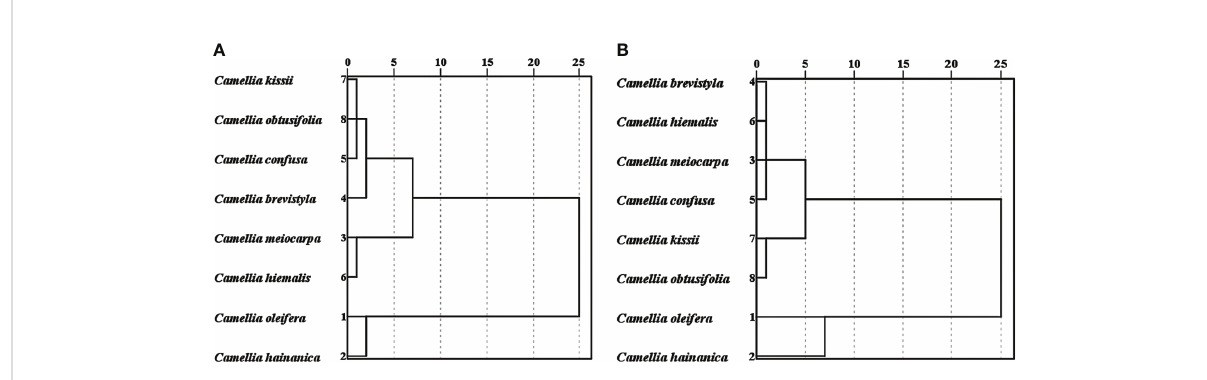
FIGURE 8 Clustering of normal pollen and pseudopollen micro-characteristics related to species. (A) Normal pollen. (B)